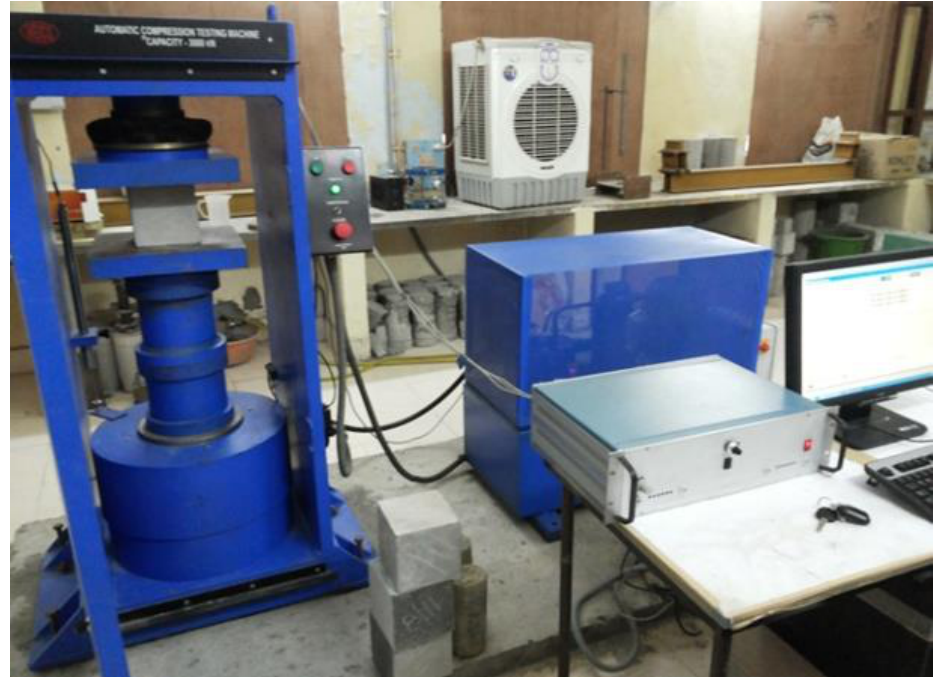
Fig. 16. Compressive strength